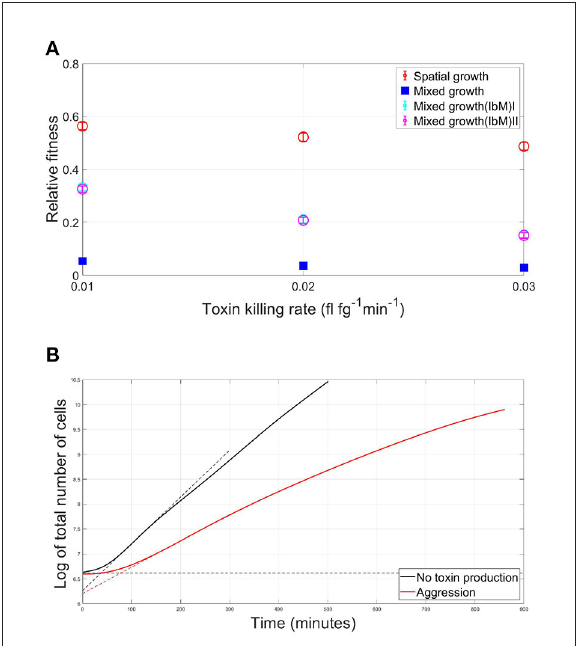
FIGURE7 (A) The average fitness of two strains engaging in mutual aggression, relative to their fitness in the no aggression scenario, in case of a spatial vs. well-mixed mode of growth, at different toxin lethalities, using three different models of mixed growth as a benchmark. Besides the initial simple mixed growth model, two additional mixed growth models have been created within the IbM environment. In Mixed growth(IbM)I , the spatial mixing effect is induced by randomizing the positions of the cells after each iteration, while in Mixed growth(IbM)II the concentrations of the toxins are made to be uniform at the horizontal direction by replacing the toxin concentration at each spatial point in each row of the environment grid by the average value of the toxins’ concentration in the row to which the spatial point belongs. (B) The effect of mutual aggression on the lag phase of a microbial community: the growth curves of the overall population in case of (i) mutual aggression scenario (red) and (ii) No aggression (black) for two strains growing together in a spatial settings as a biofilm. The duration of the lag phase is defined here as the intersection of the maximum slope at the exponential phase with the horizontal asymptote at the initial population level, shown with the dotted